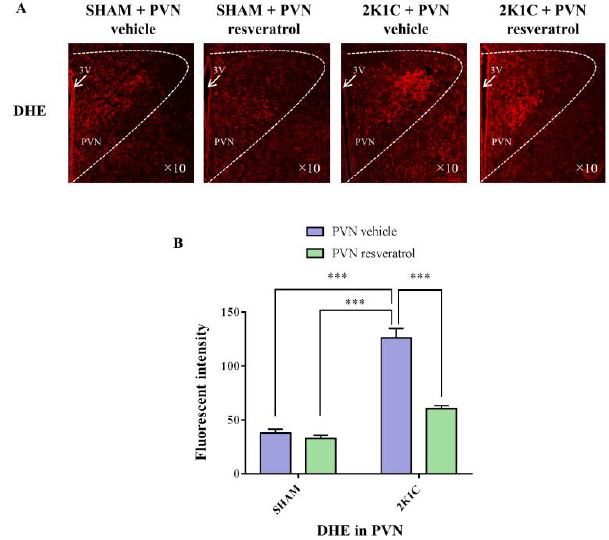
Figure 5. The effects of resveratrol on ROS in PVN. ( A ) Immunofluorescence staining of reactive oxygen species (red fluorescence, ×10) and ( B ) densitometric analysis of DHE staining. 3V: third ventricle. Values are the mean ± SEM. *** p < 0.001, n = 4.